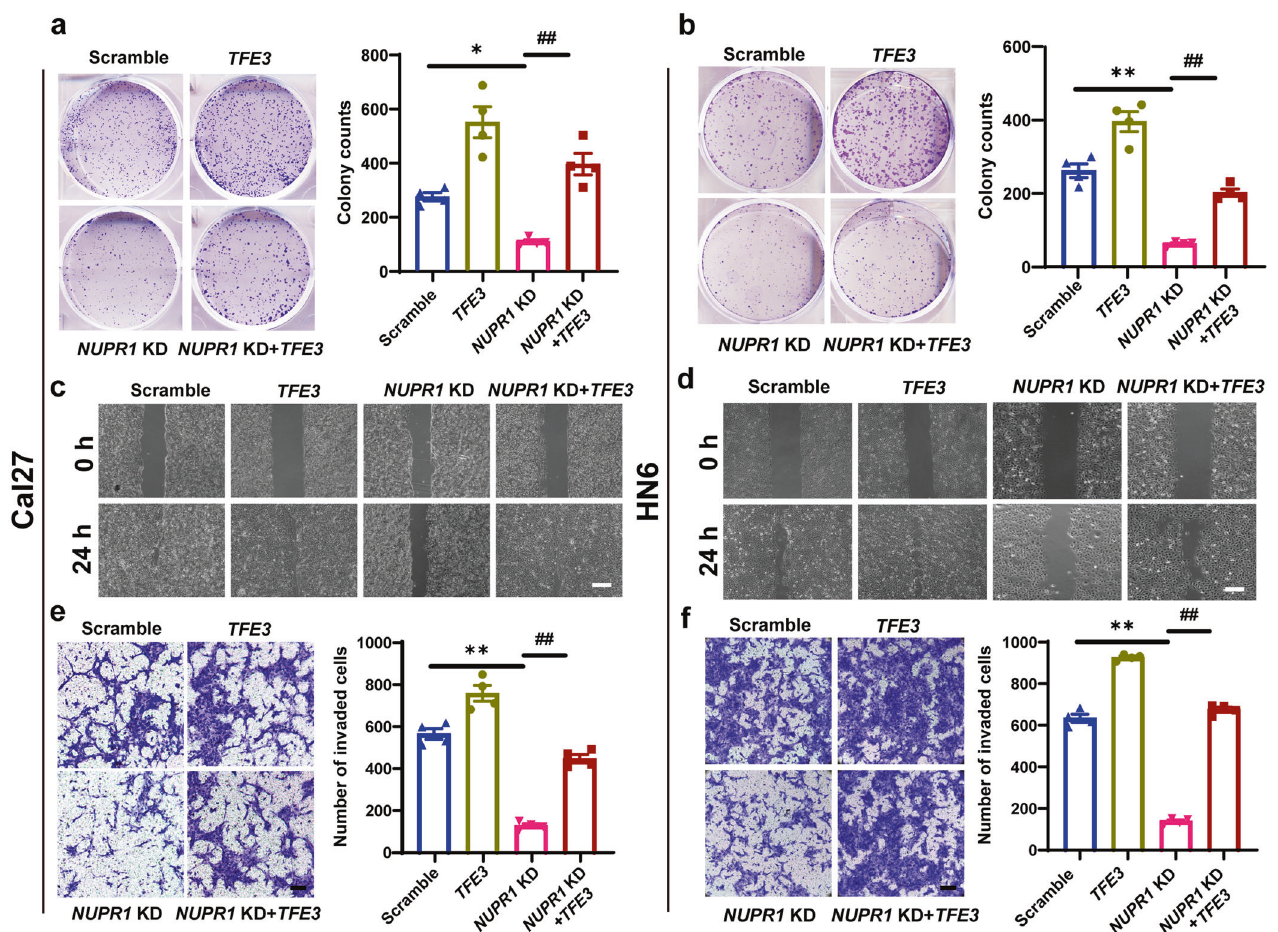
Fig. 5 a , b Representative images of colony formation and quantitative analysis results in NUPR1 KD or scrambled Cal27 and HN6 cells transfected with TFE3 plasmid or a control plasmid for 24 h; n = 4. c , d The migration results for of NUPR1 KD or scrambled Cal27 and HN6 cells transfected with TFE3 plasmid or a control plasmid; scale bar: 100 μ m. e , f The invasion results for NUPR1 KD or scrambled Cal27 and HN6 cells transfected with TFE3 plasmid or a control plasmid. Scale bar = 80 μ m; magni fi cation; n = 4; 40 ×